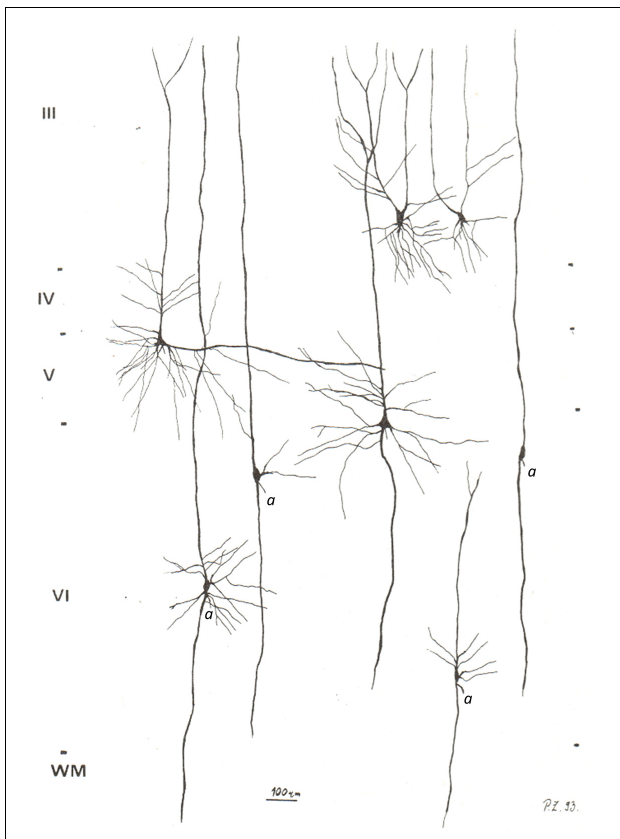
FIGURE 3 | Camera lucida reconstructions of common modified pyramidal neurons in the PFC. The axons on spindle-shaped neurons are marked by “ a ”. Note that the axon of common modified pyramidal neurons arises either from the cell body or extremely close to the cell body, unlike the distant axon origin found in VENs. Also note that common modified pyramidal neurons lack the brush-like terminal branching typical for VENs. Image modified from Petanjek and Kostovi´c